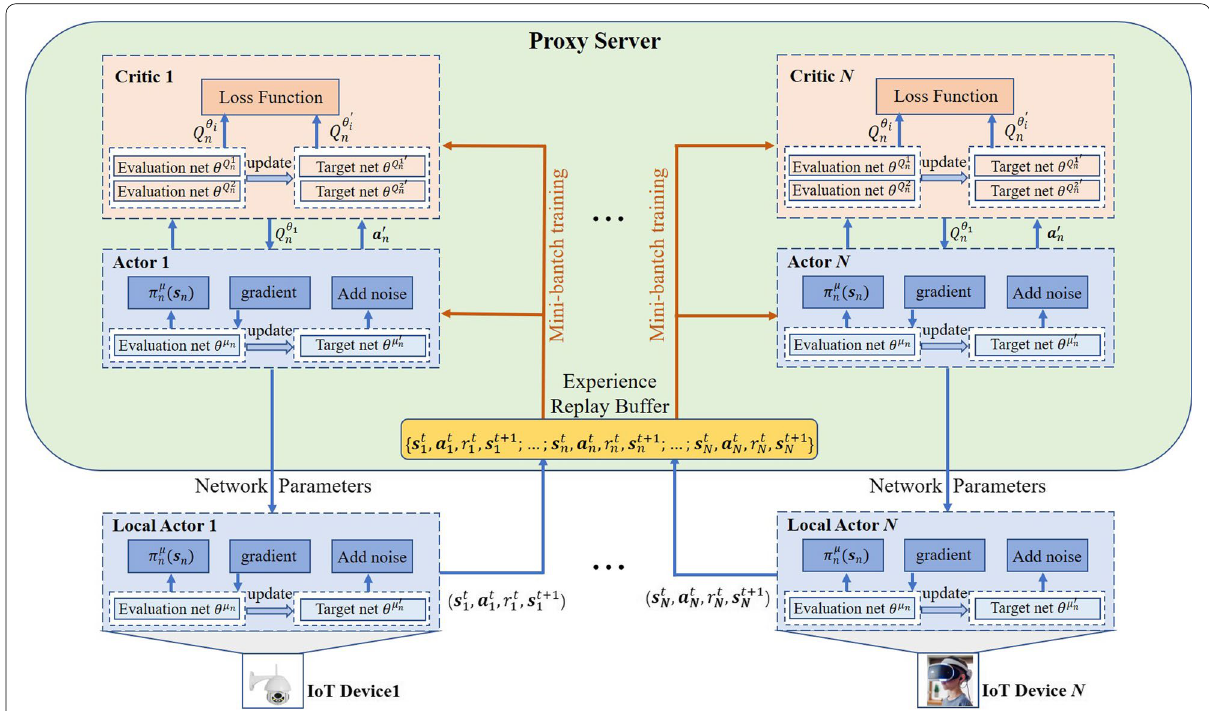
Fig. 2 The framework of proposed CMATD3 in multi-cloud